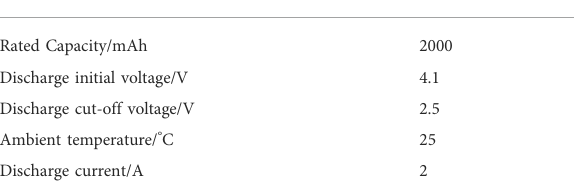
TABLE 1 Lithium-ion battery